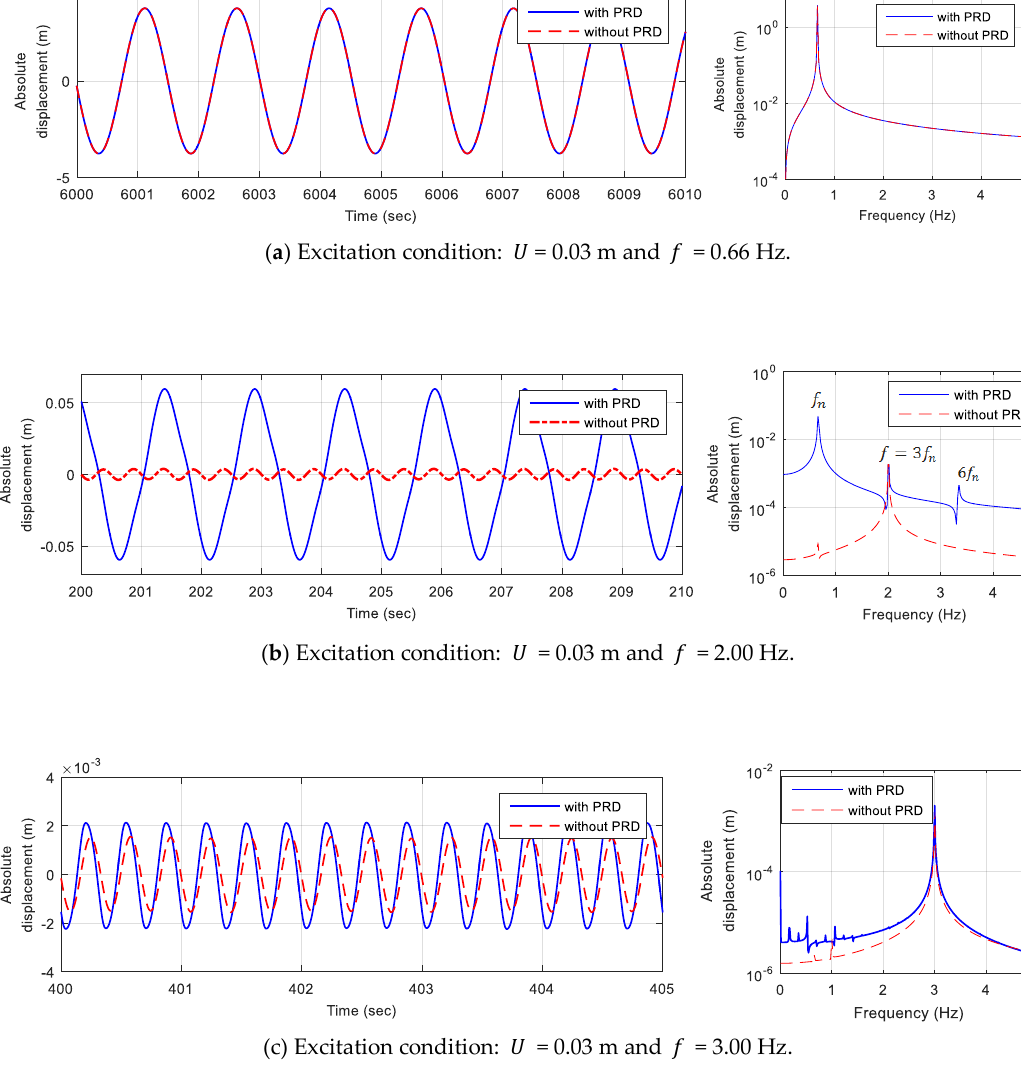
Figure 6. Steady-state response to harmonic excitation under k / M = 5 and ζ r = 0.2 .